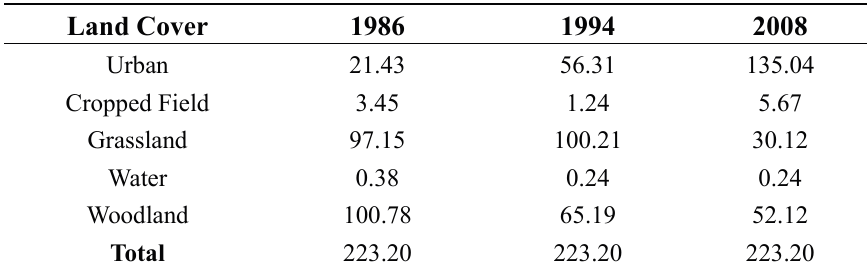
Table 10. Land conversions in the Mukuvisi catchment between 1986 and 2008 (Area is in square kilometers).